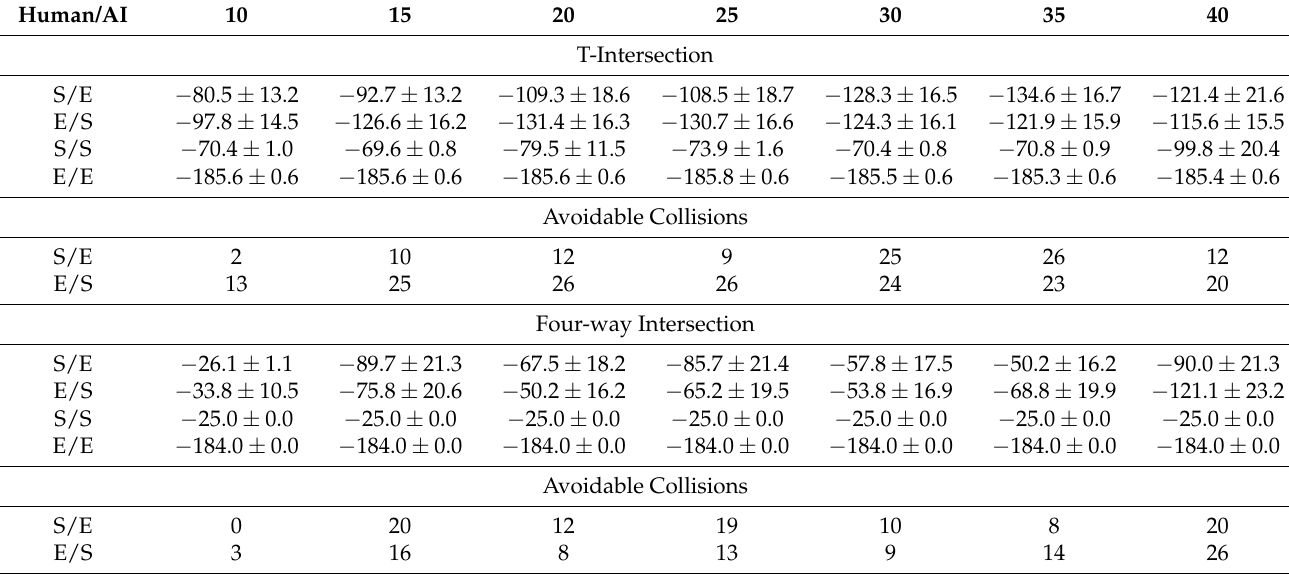
Table 19. Mean reward (by human–AI configuration) for a random manager with given delegation interval lengths in the human: sensor and mask, AI: color case.